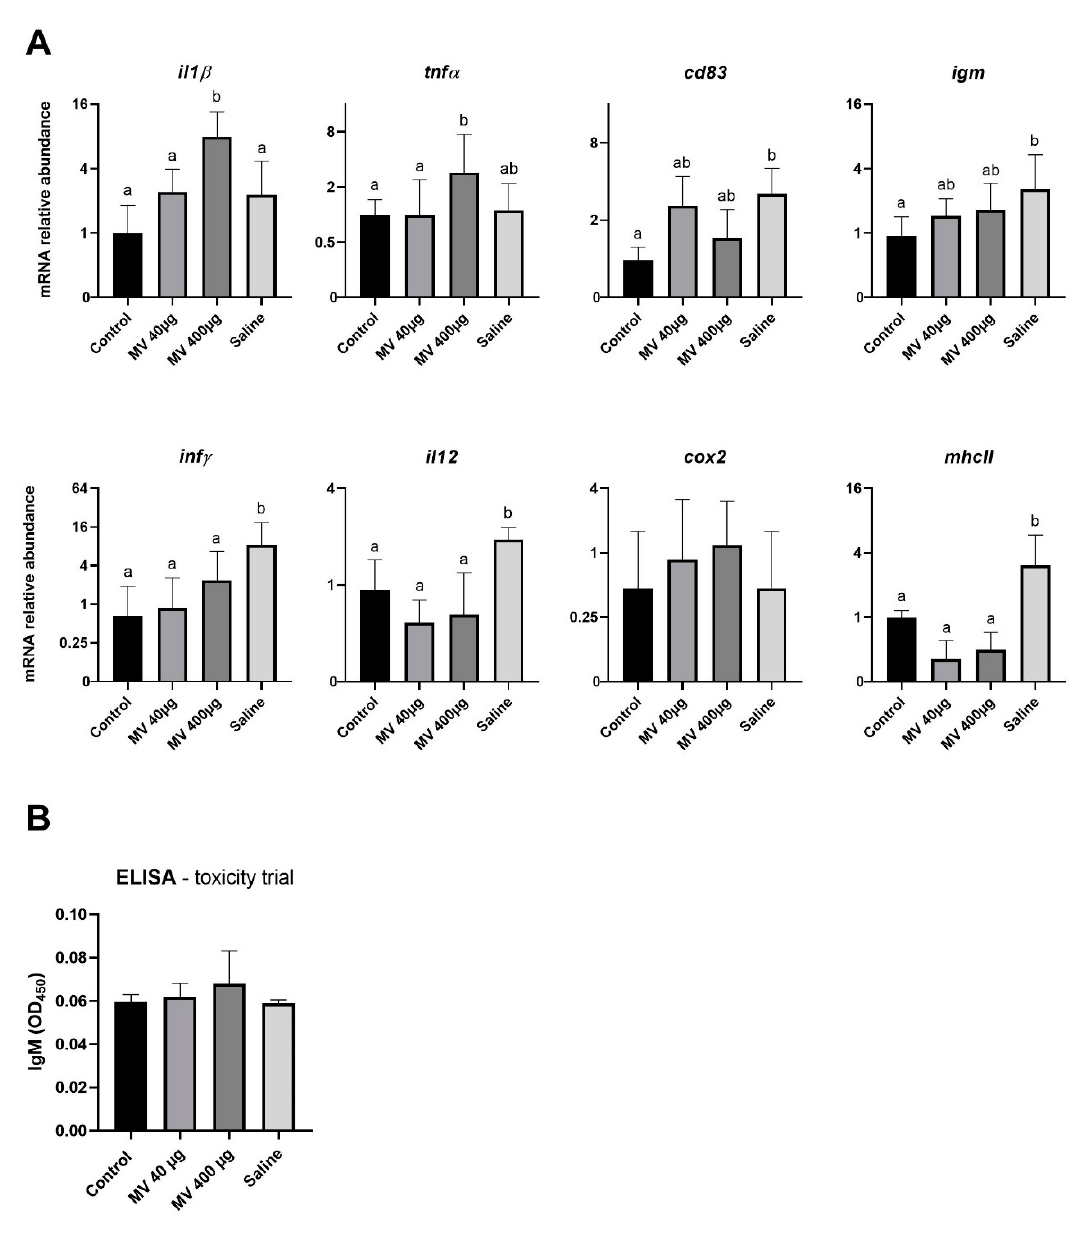
Figure 1. Immune responses in tilapia 14 days after injection of 40 or 400 µ g of Fo membrane vesicles (MVs) compared to saline-injected or untreated fish. ( A ) Log2 of relative mRNA abundance of a selection of immune genes performed by qPCR on isolated spleen from eight fish per group. ( B ) Enzyme-linked immunosorbent assay (ELISA) measuring specific IgM against Fo . Absorbance was measured at 450 nm. Labelling with different letters (a; b) indicates significant differences between groups; groups that do not share letters are significantly different. The absence of letters indicates a lack of significant differences ( p < 0.05; one-way ANOVA with multiple comparisons using Tukey test; error bars indicate mean ± SEM (standard error of the mean)). Note that the scale on Y -axis can differ in (A).